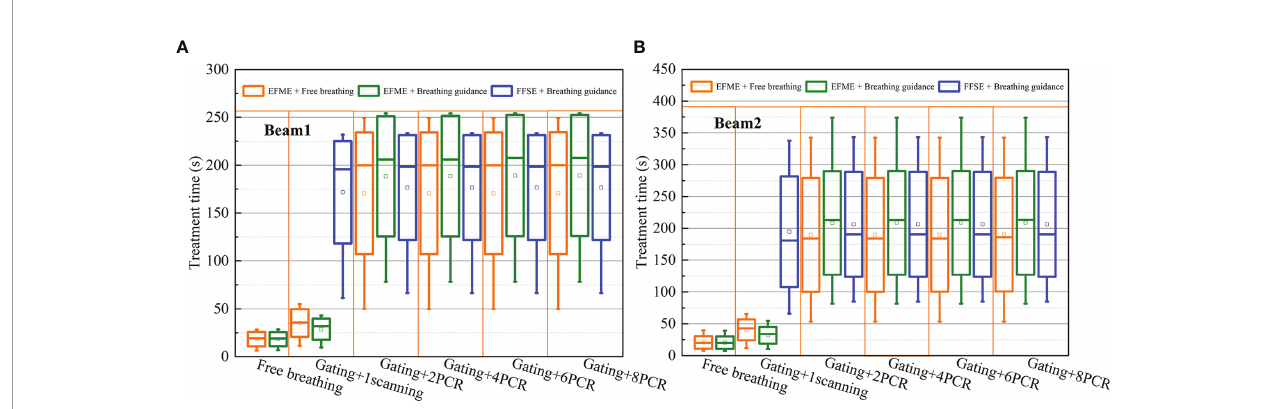
FIGURE 7 | Boxplots of the treatment time over all cases under free-breathing and breathing guidance maneuvers in combination with gating and phase-controlled rescanning (PCR) methods delivered in the extended fl attop with multi-energy (EFME) and fi xed fl attop with single-energy (FFSE) synchrotron operation modes Treatment time distributions for (A) beam1 and (B) beam2. The box plots represent one SD, the bands in the boxes are medians, and the extremes are the maximum and minimum values for each